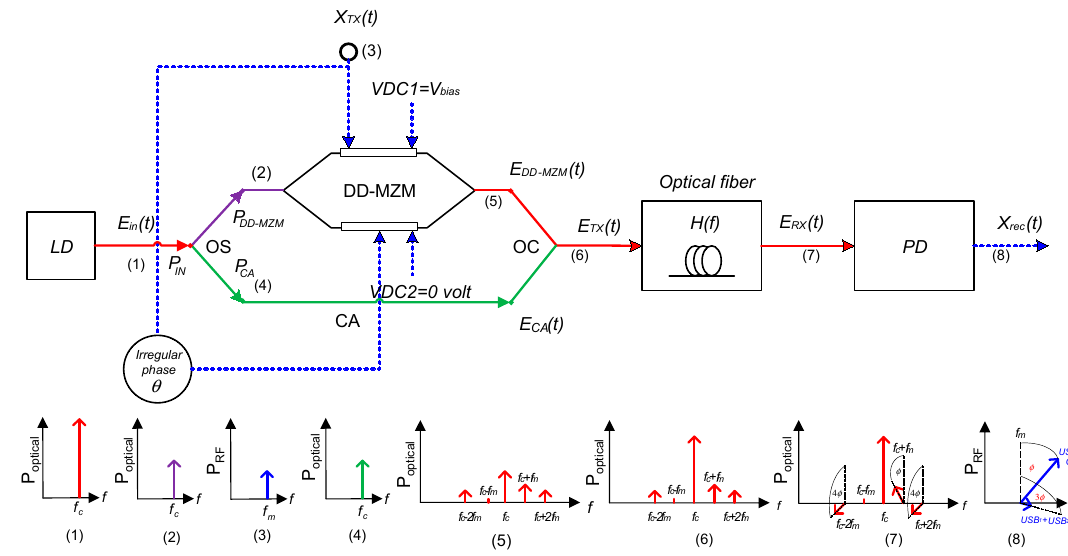
Figure 1. The proposed asymmetric carrier divider with irregular RF phase on DD-MZ modulator.